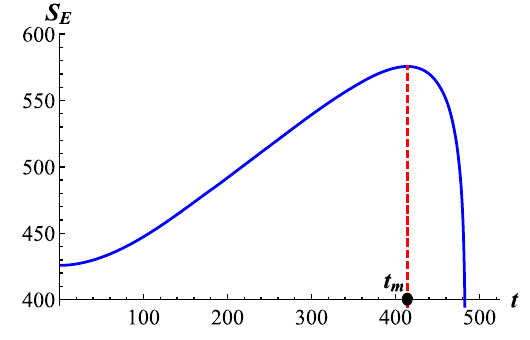
Fig. 1 We take (cid:9) = 1 / 1000, R = 100, θ o = 1 / 10 and G =